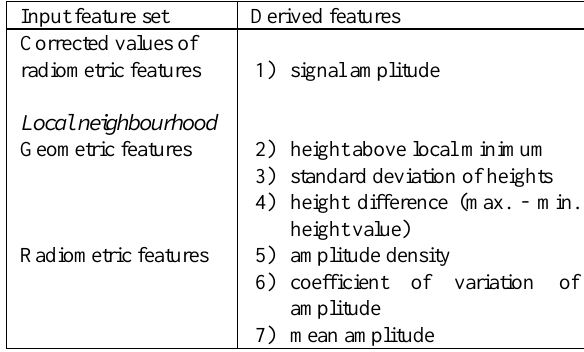
Table 1. Seven different features used for DT